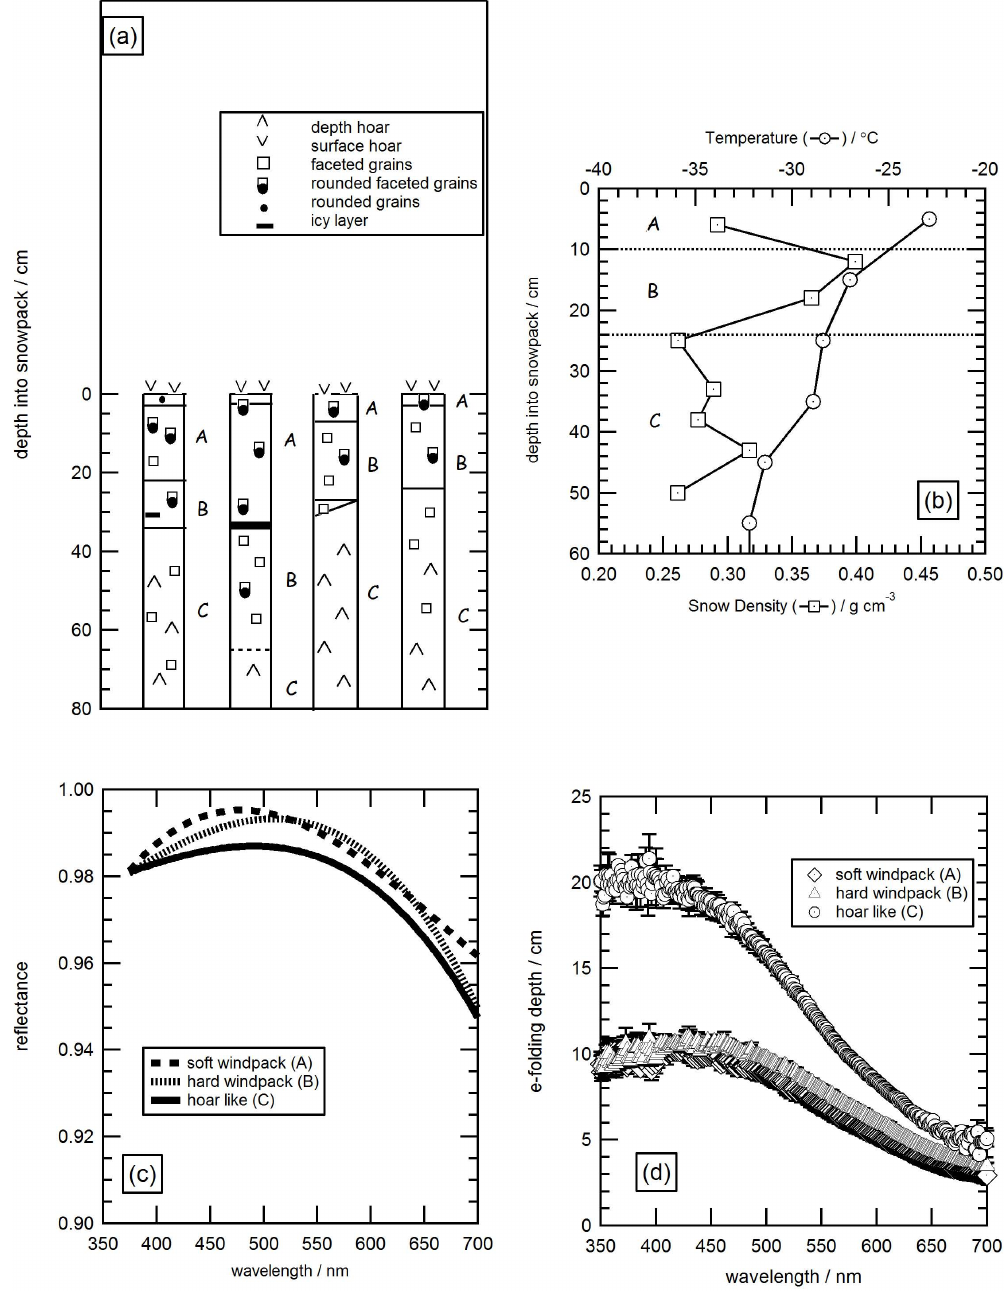
Fig. 1. (a) Snowpack stratigraphy measurements from four snowpacks at/near Dome C between 19 December 2009 and 13 January 2010 to demonstrate the uniformity of the snowpack in the area, symbols used from the International classification of snow on the ground (Fierz et al., 2009). Layers are summarised into A, B and C as referred to in the text and tables in the rest of the paper as soft windpack (A), hard windpack (B) and hoar-like (C). The average snowpack stratigraphy as measured is shown in Table 1. (b) Measured snowpack temperature and density profiles for the snow layers from the snowpack measured on 6 January 2010, a typical snowpack stratigraphy for the sampled region. Temperatures measured at local noon. (c) Nadir reflectivity versus wavelength measured for each of the snowpack layers corresponding to the e -folding depth measurements in Fig. 1d, 2 standard deviation errors are typically 1.5% from the mean and are omitted for clarity. (d) Comparison of median e -folding depths versus wavelength for each of the snowpack layers, error bars are 2 standard deviation from the median e -folding